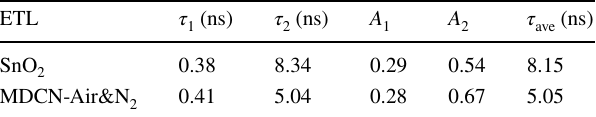
Table 2 The fitted results of TRPL for various ETLs ETL